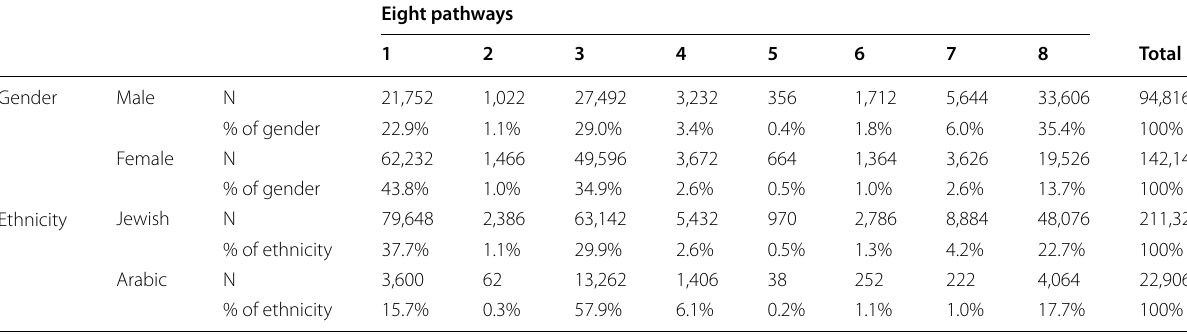
Table 5 The distribution of demographic characteristics according to the eight pathways Eight